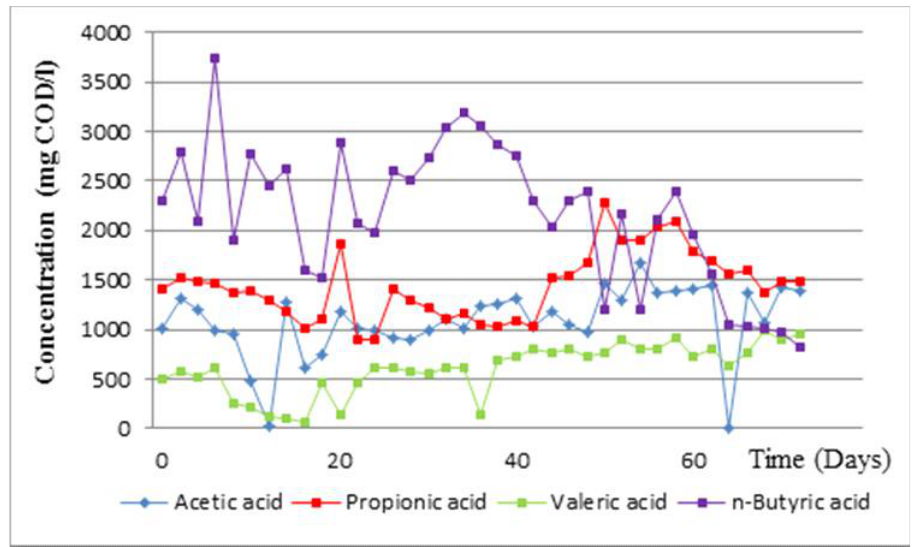
Fig. 1: Evolution of the concentrations of the VFAs in the fermented material